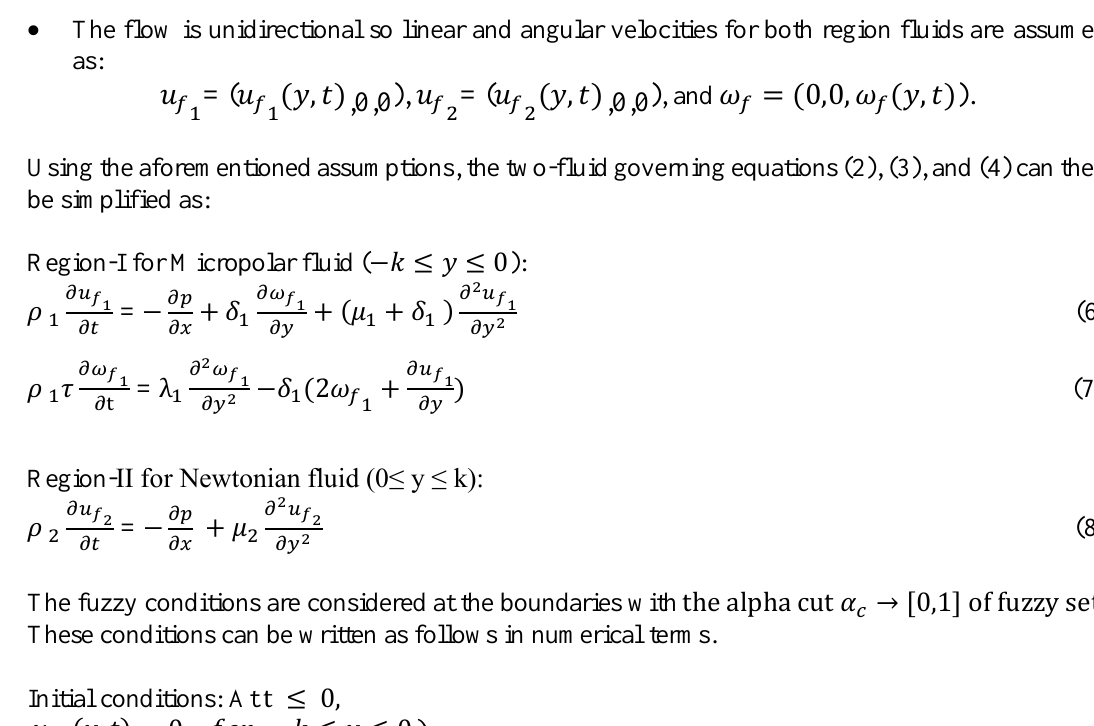
with its membership 𝒃,𝒅 𝒄 ,𝒊 𝒄